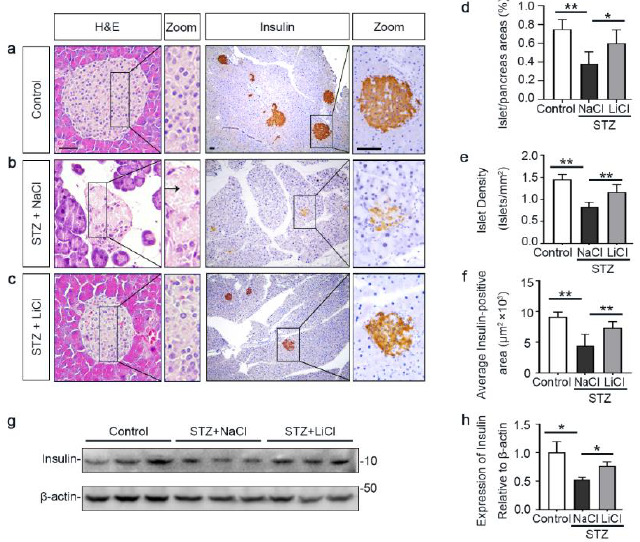
Figure 2. Lithium therapy preserves the histology of pancreatic islets and retains β -cell production of insulin in STZ-injured mice. Animals were treated as elaborated in Figure 1. ( a – c ) Representative micrographs demonstrate hematoxylin–eosin (H&E) staining of pancreas procured from animals on day 12 and peroxidase immunohistochemical staining for insulin. STZ injury induced apparent islet damages, characterized by pancreatic islet necrosis, as indicated by the arrow. These damages were significantly mitigated by lithium treatment. Scale bar = 50 µ m. Computerized morphometric analysis determined ( d ) the percentage of islet/pancreas areas, ( e ) islet density and ( f ) average insulin-positive areas. Data were presented as mean ± SD; * p < 0.05, ** p < 0.01 ( n = 5). ( g ) Pancreatic islets were isolated from the pancreas by collagenase digestion and density gradient centrifugation. Homogenates of isolated islets were prepared for immunoblot analysis for insulin and β -actin. ( h ) The expression levels of insulin were quantitated by densitometry and normalized with β -actin levels. Data were expressed as fold changes over control and presented as mean ± SD; * p < 0.05 ( n = 5).